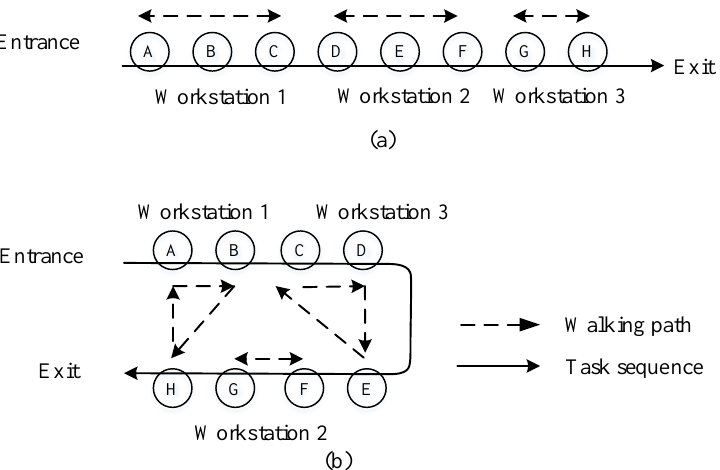
Figure 1. An example of production types. ( a ): traditional straight production line; ( b ): U-shaped production line.